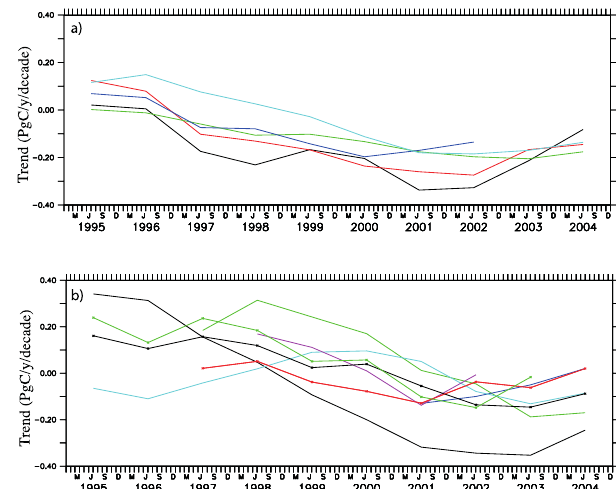
Fig. 10. Trends in ocean carbon uptake in the Southern Ocean be- tween 44–75 ◦ S over different decadal periods (see text for expla- Figure 10 Trends in ocean carbon uptake in the Southern Ocean between 44 ° S-75 ° S 1258 nation) in units of PgCyr − 1 decade − 1 . The upper panel shows the over different decadal periods (see text for explanation) in units of PgC/y/decade. The 1259 trends for individual ocean biogeochemical models and the lower upper panel shows the trends for individual ocean biogeochemical models and the 1260 panel shows the trends from individual atmospheric inverse mod- lower panel shows the trends from individual atmospheric inverse models. Negative 1261 els. Negative trend values reflect increasing flux into the ocean over trend values reflect increasing flux into the ocean over each decadal period. 1262 each decadal